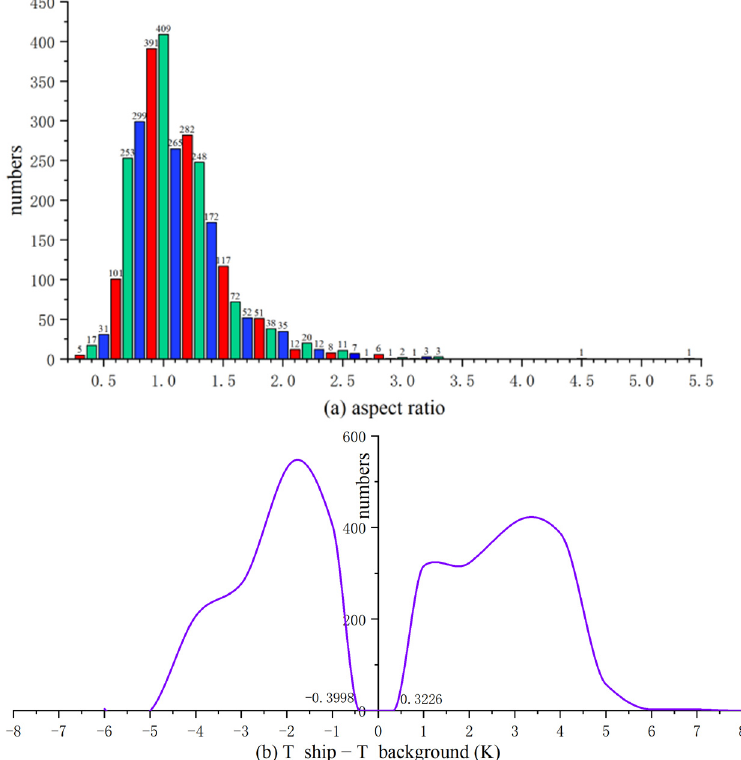
Figure 5. Statistical results of ( a ) aspect ratio of ship target bounding box and ( b ) the brightness temperature on the pupil (T/K) between the ships and sea surface in 8~10.5 µm in the TISD.